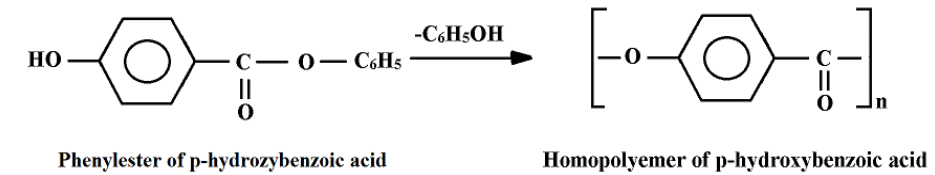
Figure 6. Aromatic polyester chemical structure [56].